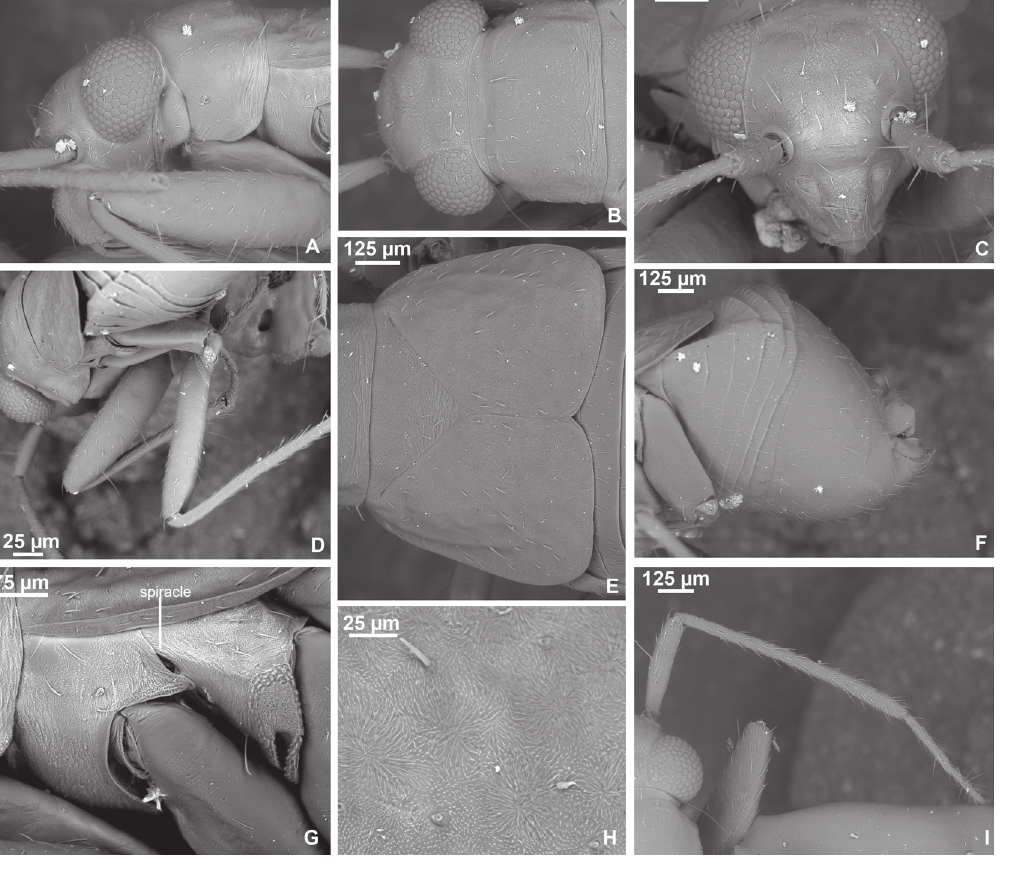
Fig. 3. SEM images of C. ovatum sp. nov., ♂. A . Head and pronotum, lateral view. B . Head and pronotum, dorsal view. C . Head, anterior view. D . Fore- and middle femora. E . Scutellum and hemelytra. F . Genital segment, lateral view. G . Pleura. H . Setae on hemelytron. I .